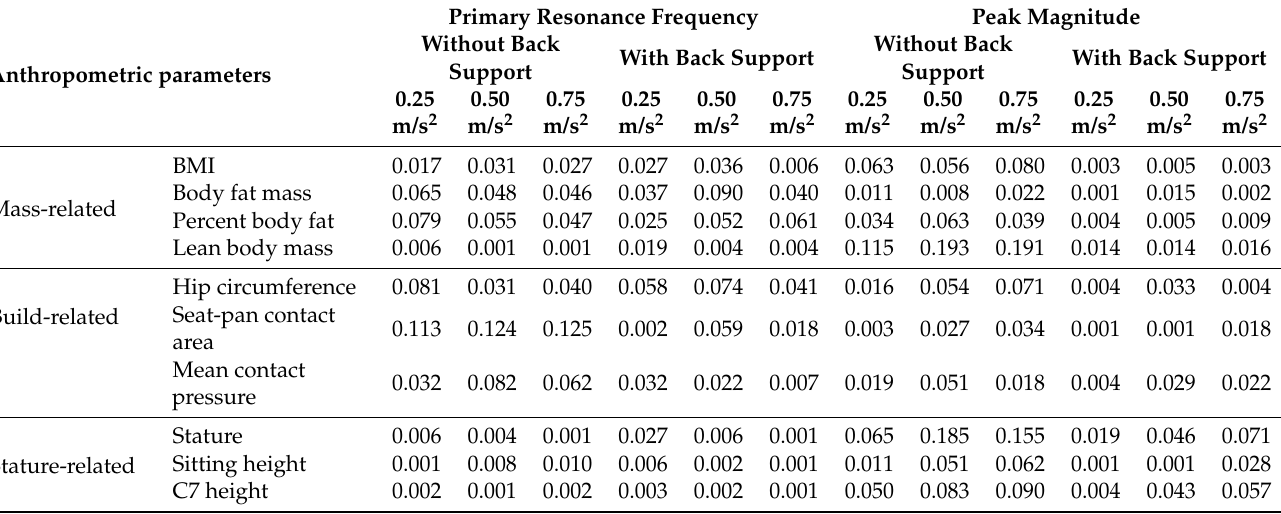
Table 8. Values of r 2 between anthropometric parameters and the peak fore-aft STHT magnitude, as well as primary resonance frequency, for the three excitations and the two sitting conditions for seat